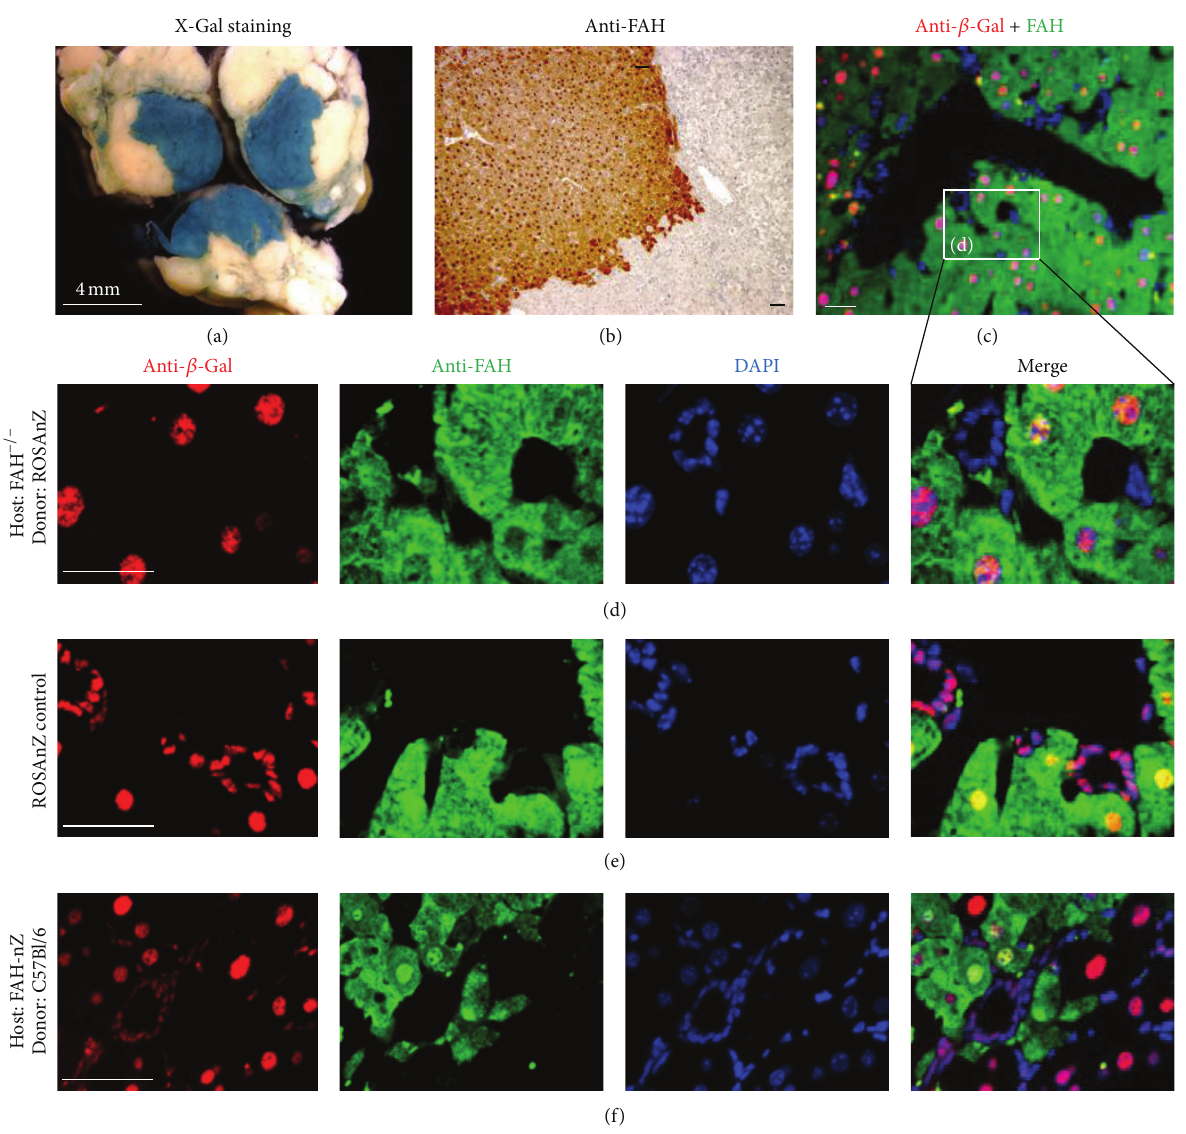
Figure 3: Reconstruction of liver functional units. Strong expression of 𝛽 -Gal was detected in regenerating nodules by whole-mount X-Gal staining of FAH mutant livers (a) and expression of Fah in liver sections by Fah staining (b). Formation of remodeling liver functional units was observed in the regenerating nodules of Group 1 after BMT (c). (d) Higher power view of the indicated region in (d). (e) Intrahepatic biliary architecture in a liver section from a ROSAnZ control mouse. (f) Ductular structures in the regenerating nodules of a 𝐹𝑎ℎ −/− -ROSAnZ mouse that received C57Bl/6J BMCs (Group 2). Scale bars are 60 𝜇 m except for (a) (4